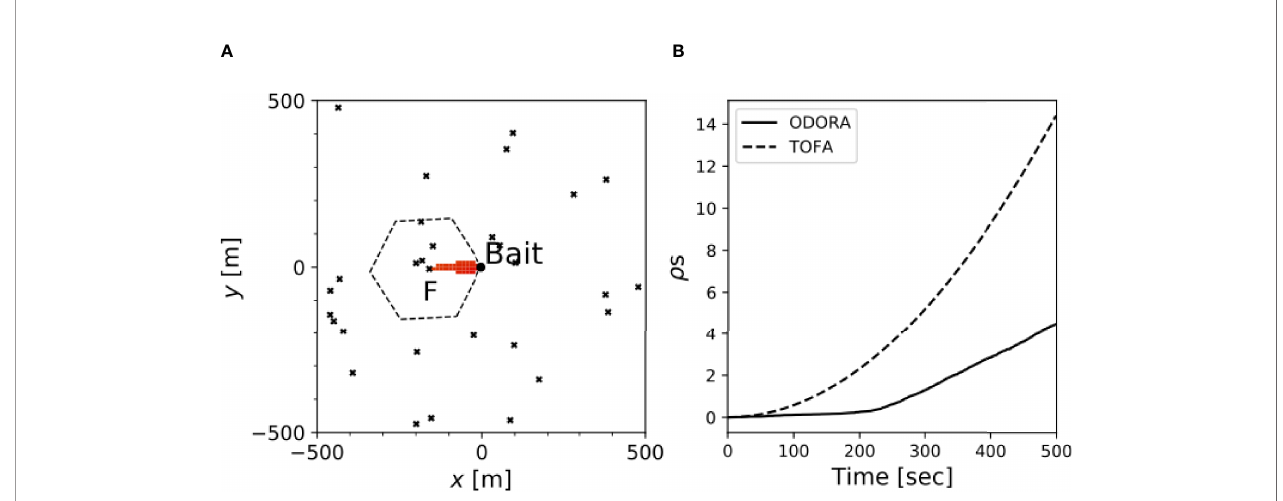
FIGURE 5 | (A) Difference in the area enclosing the fi rst fi sh, labeled F, between ODORA (in red) and TOFA methods (dashed hexagon). The fi sh positions in this panel show an example of the random dispersion pattern; (B) Time evolution of the area increment for each